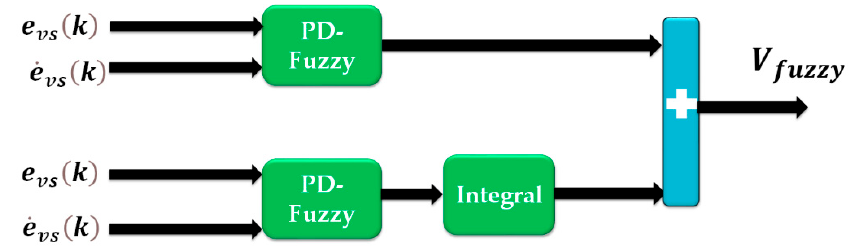
Figure 4. Proposed PID fuzzy observer to evaluate the PID V-structure.